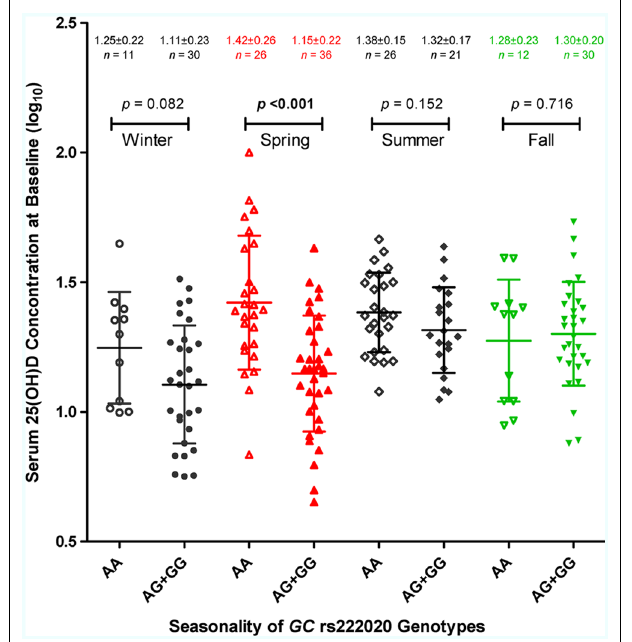
FIGURE 3 | Season-dependent association of GC genotypes with serum 25-hydroxyvitamin D [25(OH)D] concentration. The log 10 -transformed 25(OH)D (ng/ml) values in 192 HIV-1-infected youth are plotted according to four enrollment seasons and three genotypes defined by the GC SNP, rs222020 (major allele A and minor allele G). For each stratum, the horizontal bars connected by a vertical line correspond to the mean ± standard deviation (SD).The nominal p values are based on Student’s t -test, assuming a dominant effect of allele G (see Table 6 for full analyses of interactions between rs222020-G and enrollment